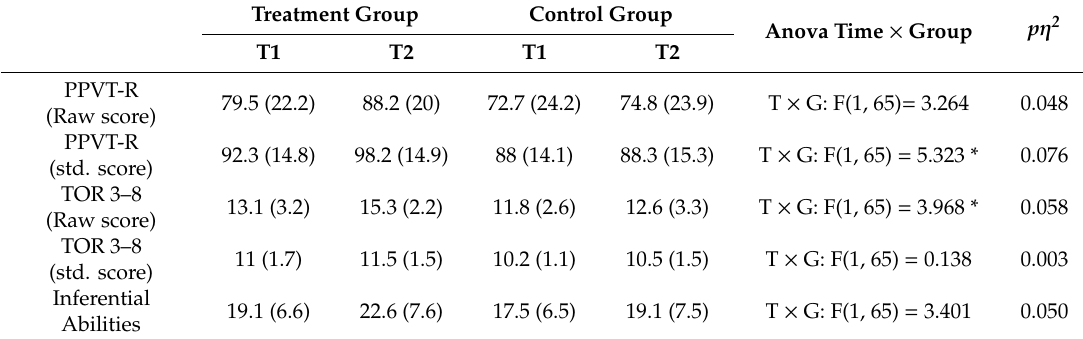
Table 3. Mean (SD) on distal abilities at T1 and T2 and group comparisons.